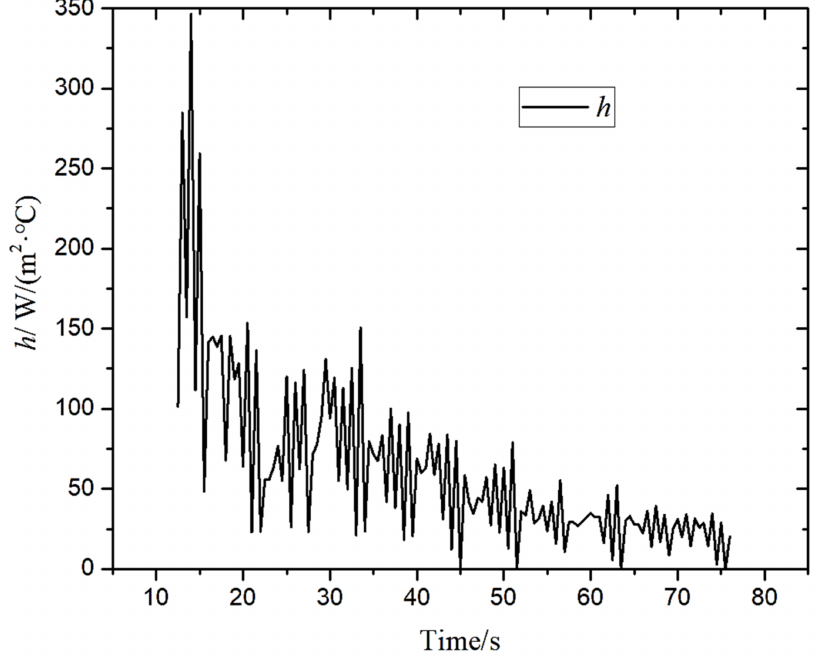
Figure 6. The change of the integrated convection heat transfer coefficient with time at the sur- face